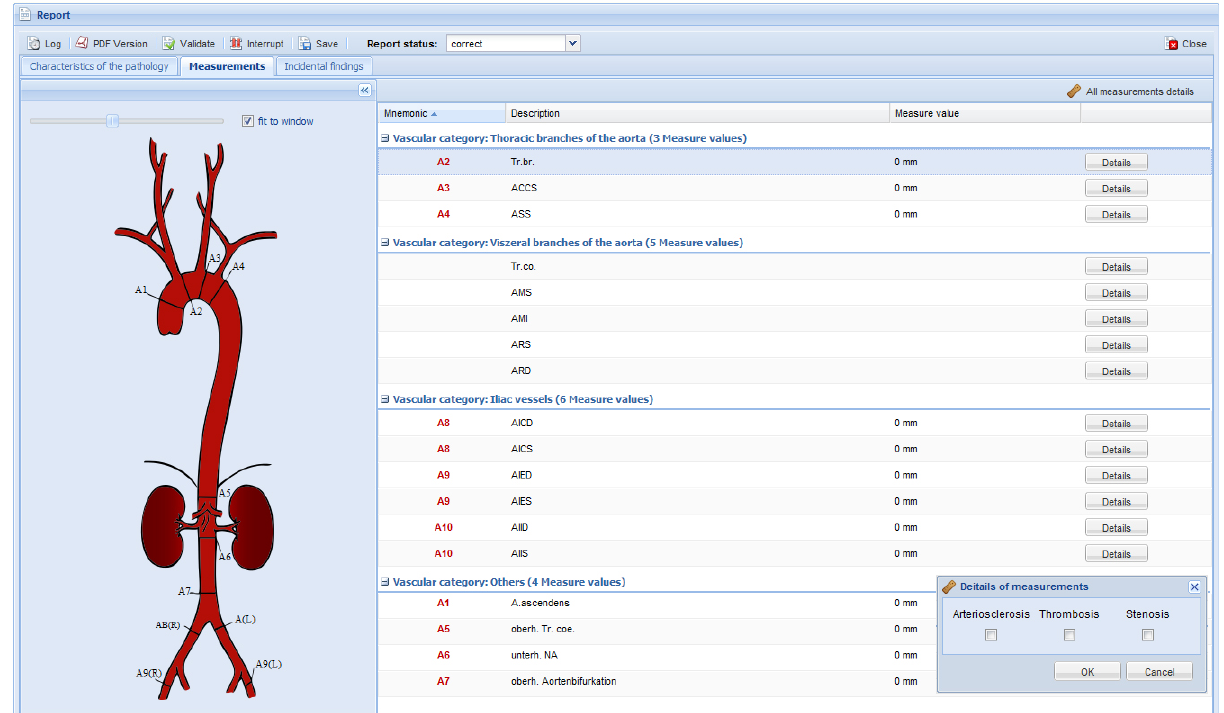
Figure 4. A1-A7 measurement positions depend on individual pathology. A8-A10 request the minimum diameter in case of stenosis or maximum in case of